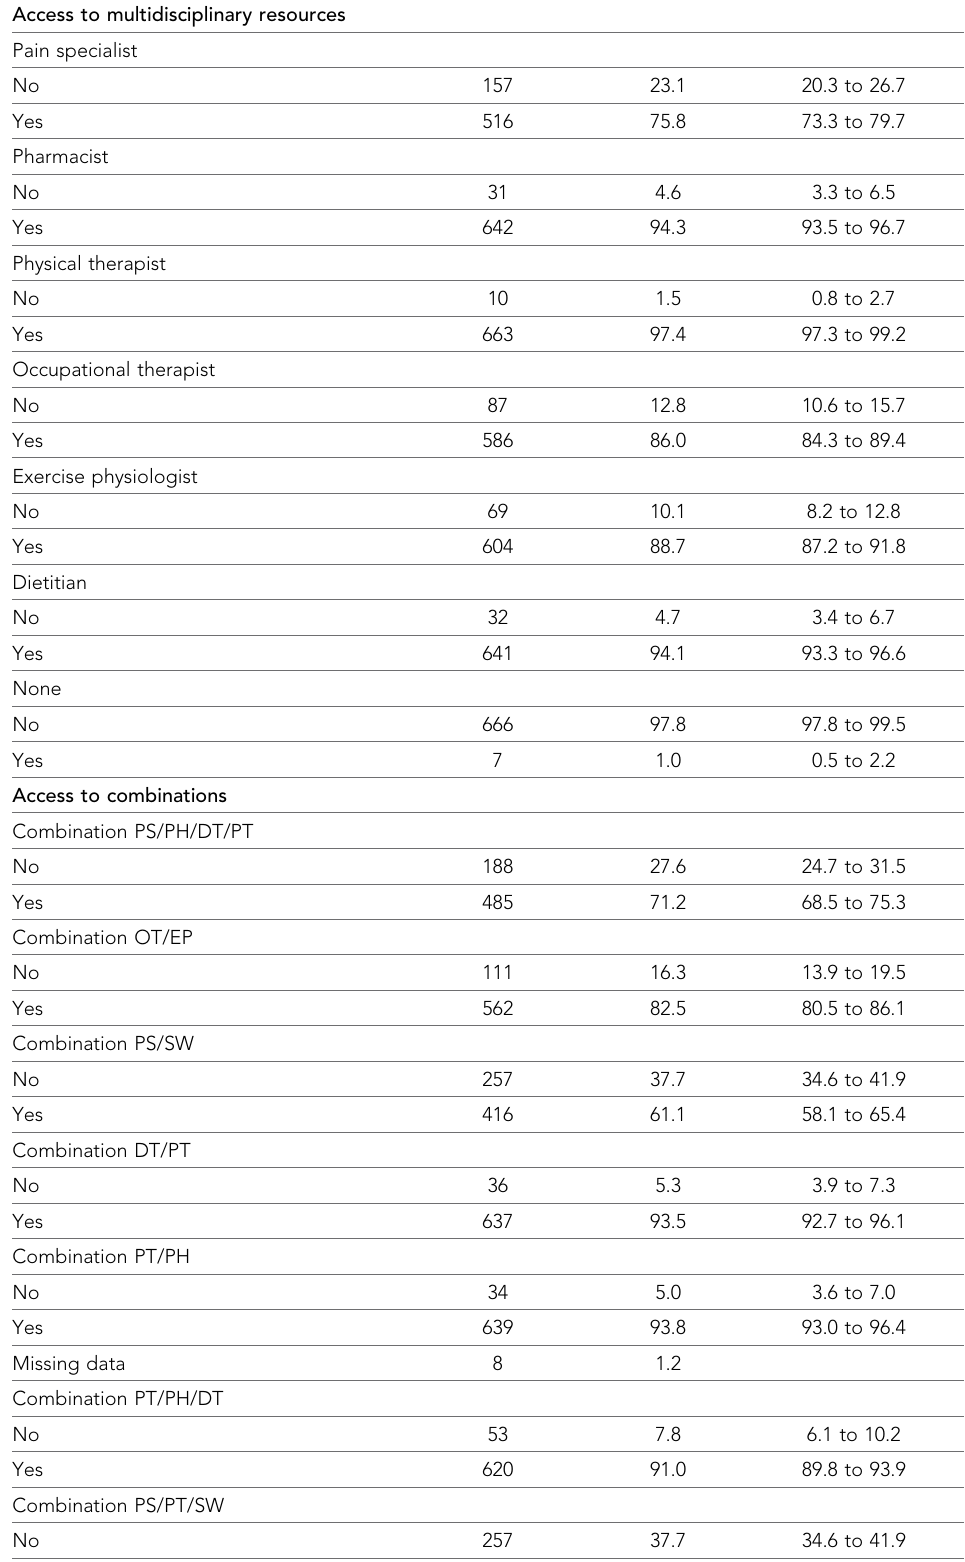
Table 2. Availability of resources within 50 km of main practice (for a